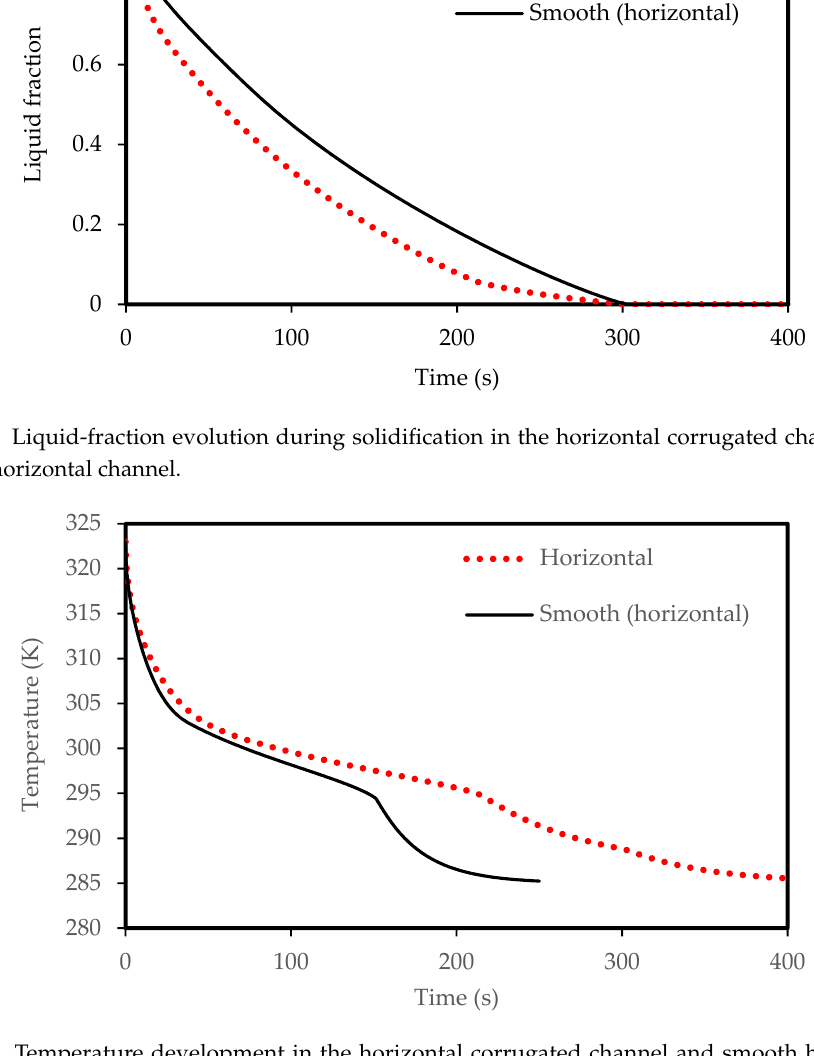
Figure 8. Temperature development in the horizontal corrugated channel and smooth horizontal channel for the solidification process.